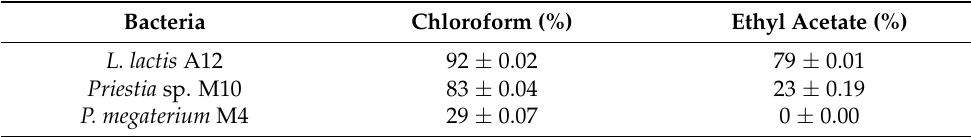
Table 4. Hydrophobicity evaluation of A12, M4, and M10.